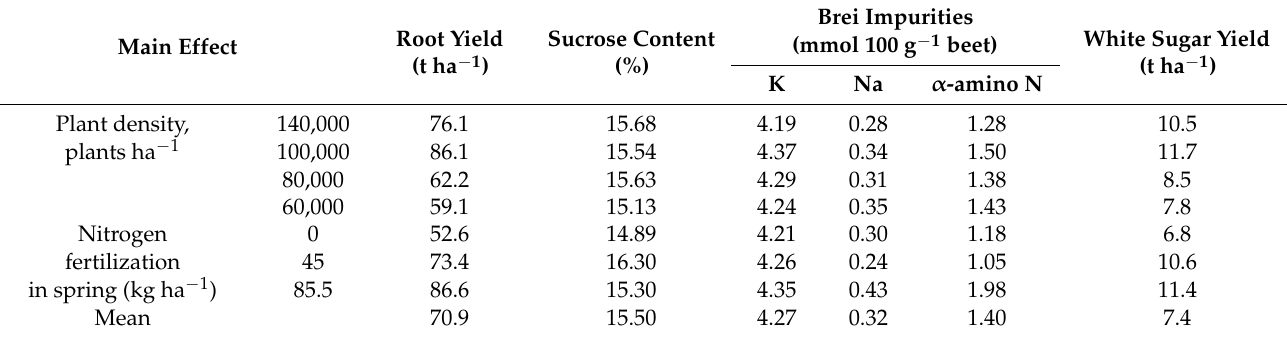
Table 4. Sugar beet root yield, quality, and sugar yield as affected by different plant densities and nitrogen fertilization rate in